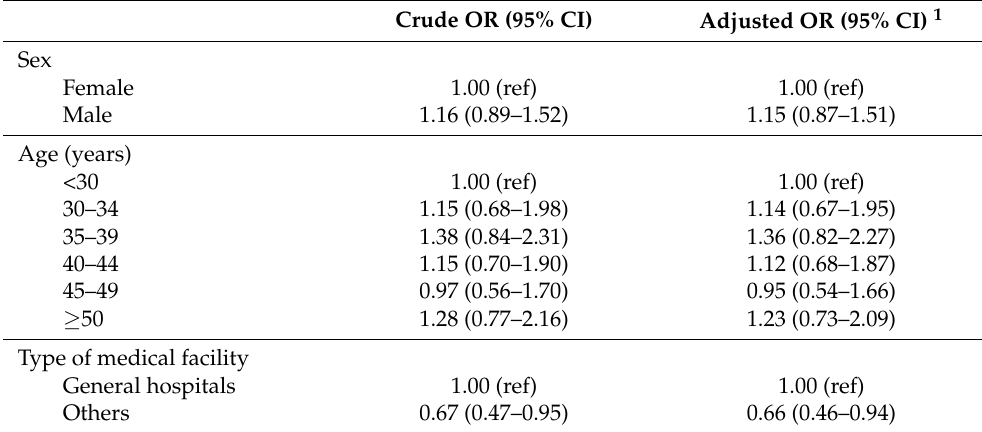
Table 3. Ordinal logistic regression analyses of the low dosimeter wearing compliance by occupa- tional